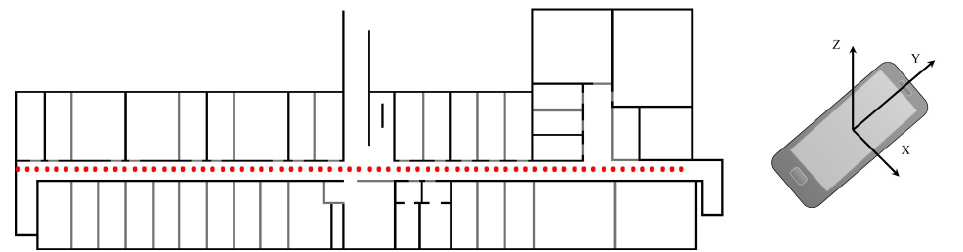
Figure 6. Fingerprinting points in IT building ( left ); and magnetometer axes on the smartphone ( right